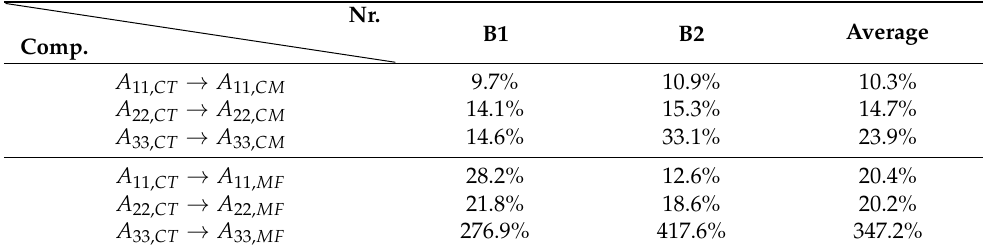
Table 4. Relative deviation provided in [23,50]. Figure averaged orientation tensors from experiment A ij , CT and simulation A ij , CM , A ij , MF of PPAGF50 on component level (B1–B2). Nr. B1 Comp.